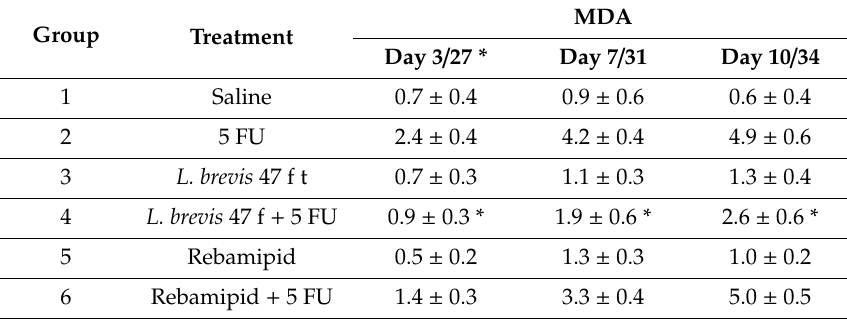
Table 3. Time course of malonic dialdehyde (MDA) levels in the male intestine.